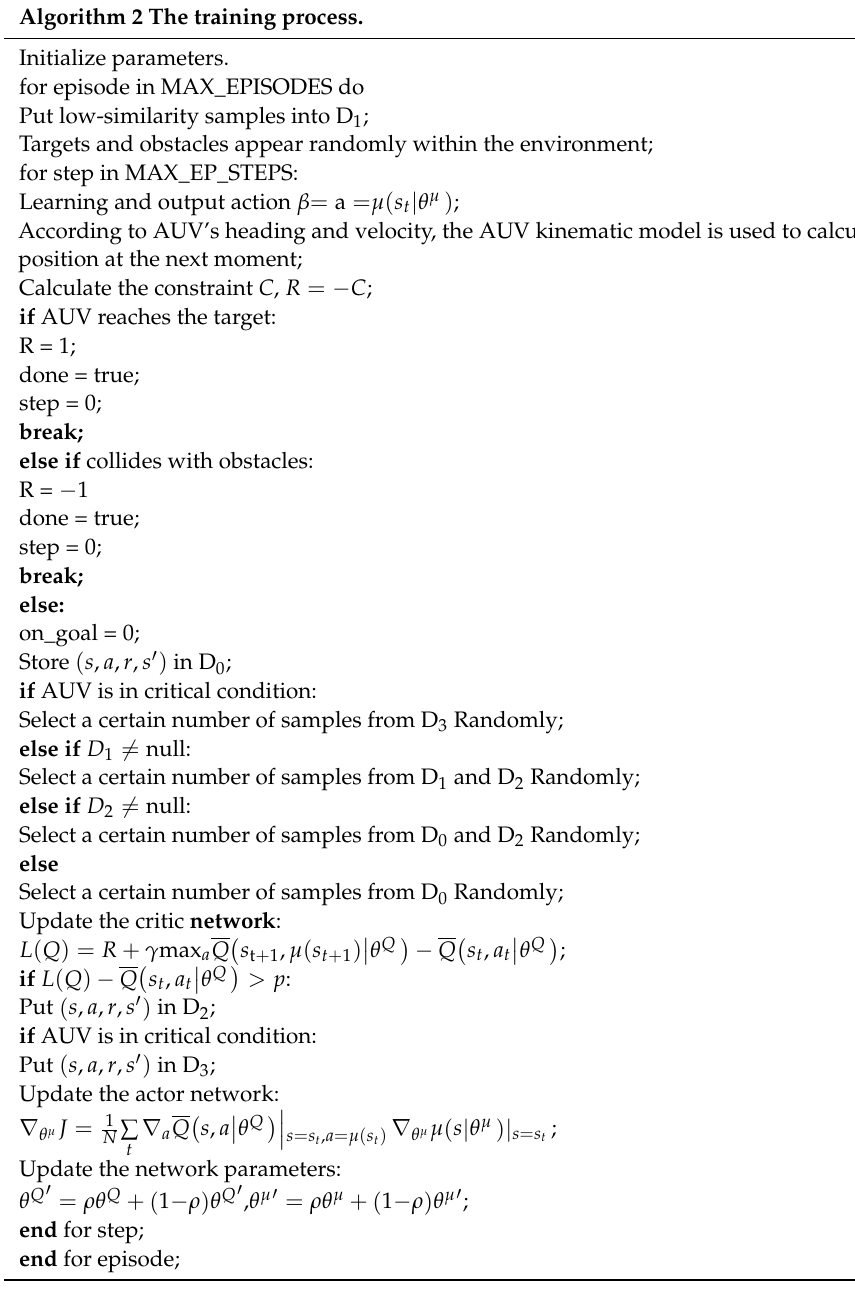
Algorithm 2 The training